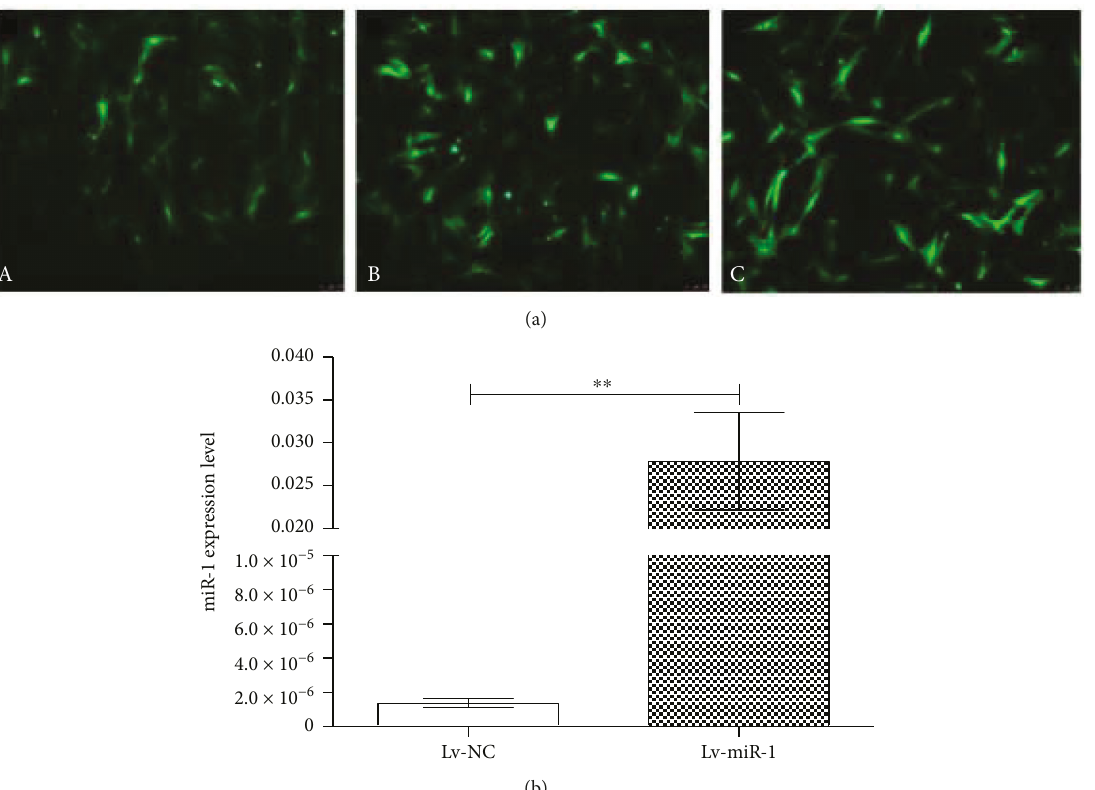
Figure 3: ASCs infected with microRNA-1 lentivirus. (a) Immuno fl uorescence microscopy of GFP in ASCs infected with miRNA-1 lentivirus. GFP expression in ASCs after 48 h infection with miRNA-1-expressing lentivirus at (A) MOI = 40 , (B) MOI = 60 , and (C) MOI = 80 . (b) miR-1 expression level in miR-1-expressing ASCs. qPCR for miRNA-1 expression in 4th-generation ASCs infected with miRNA-expressing lentivirus (Lv-miR-1 group) or control lentivirus (Lv-NC group). ∗∗ P < 0 01